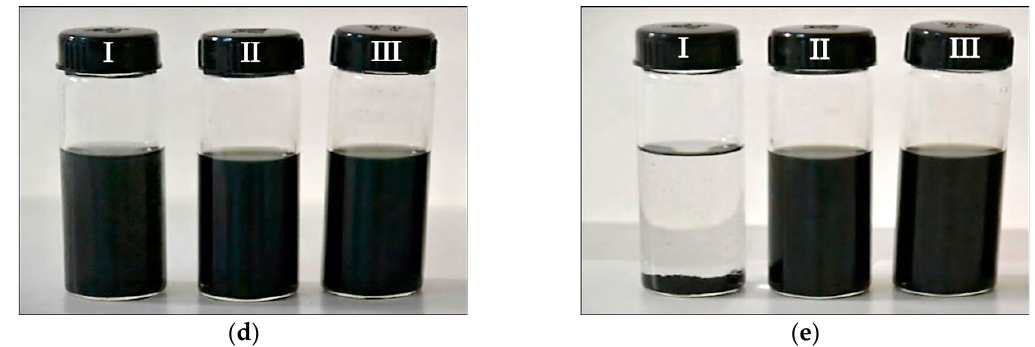
Figure 3. Optical images and high resolution transmission electron microscopy (HRTEM) (inset) micrographs of ( a ) MWCNT-NH 2 , ( b ) MWCNT-BuGE and ( c ) MWCNT-BeGE. The sedimentation behavior of (I) MWCNT-NH 2 , (II) MWCNT-BuGE and (III) MWCNT-BeGE in the ethanol solution after standing for ( d ) 1 h and ( e ) 24 h under 25 °C.